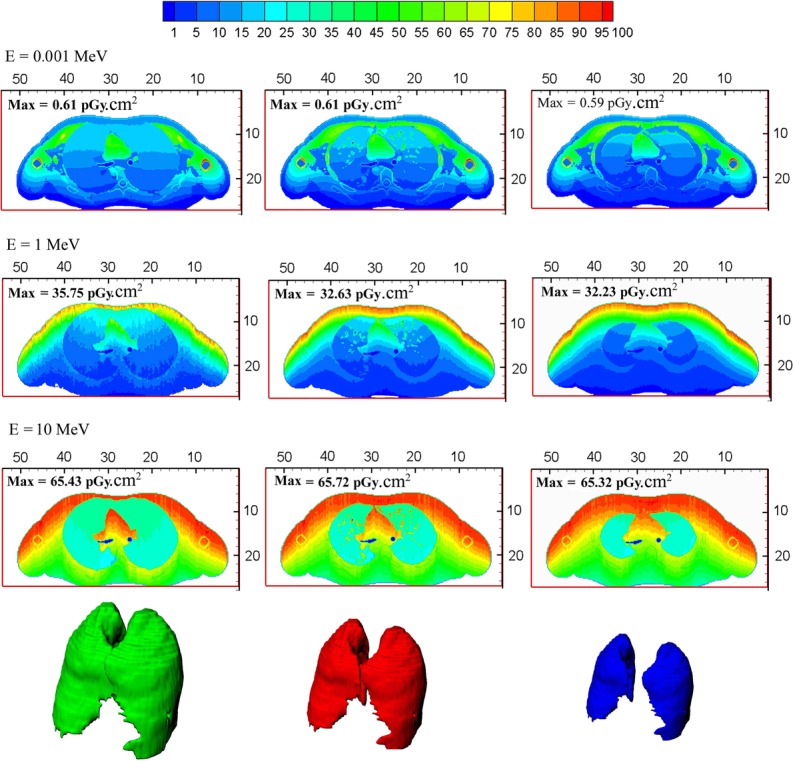
Deposited energy distribution due to recoiled protons in anterior–posterior irradiation. Three different neutron energies (0.001, 1 and 10 MeV) are considered here. The plots in the first column belong to the phantom with the largest lung. The third column shows the plots of the phantom into which the smallest lung has been imported. Finally, the middle column corresponds to the ICRP phantom with the normal lung. Images in each particular row had similar conditions in terms of the energy of the incident neutrons.